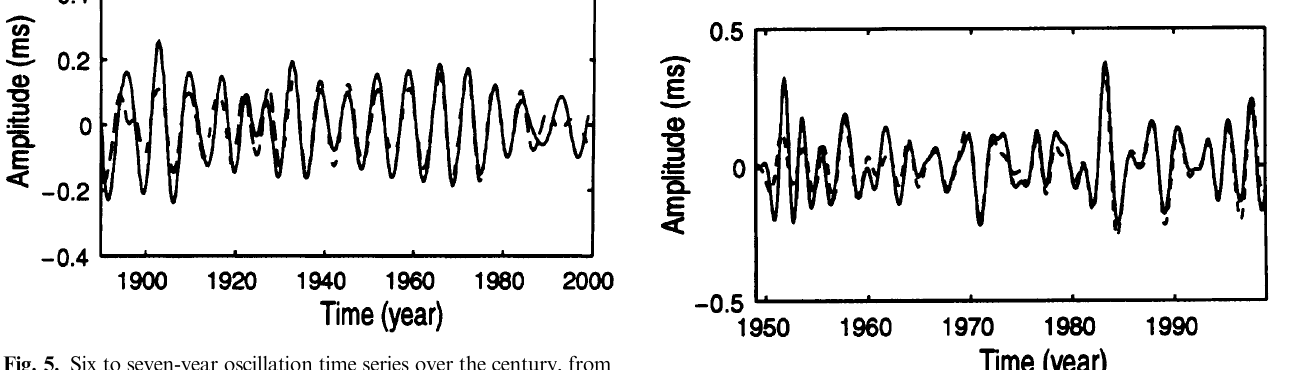
Fig. 5. Six to seven-year oscillation time series over the century, from a singular spectrum analysis (SSA) with an embedding dimension of 8 years ( solid ) and from a wavelet based filter, 5.5 to 8 years on LOD ( dashed )